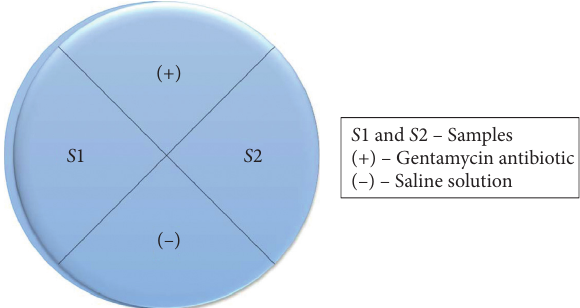
Figure 7: Illustration of the labeling of Petri